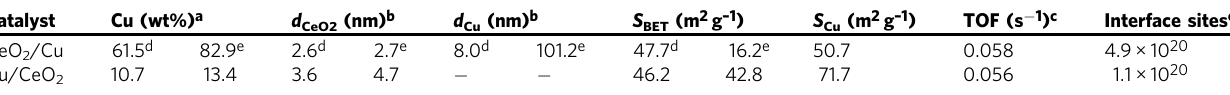
Table 1 Physicochemical properties of fresh and used